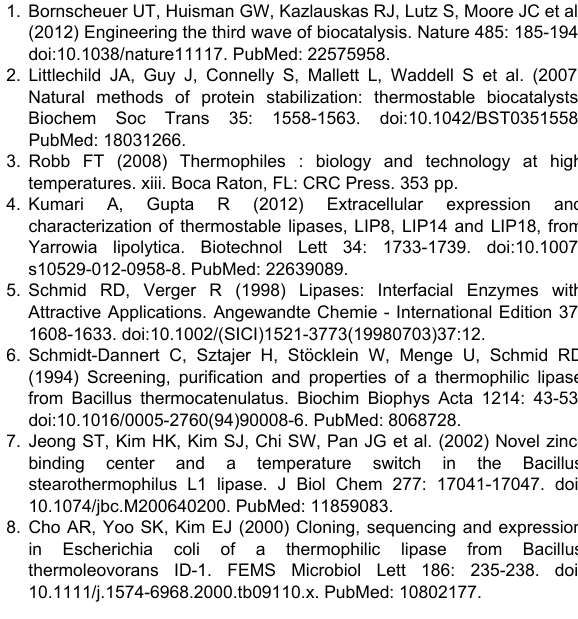
Figure S4. Thermoactivity of BTL2 and W234A.